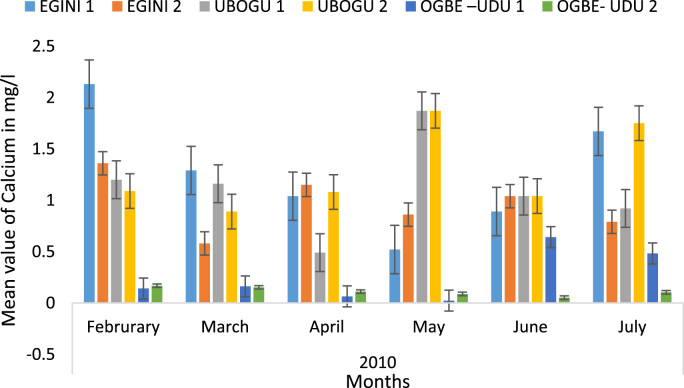
Mean Temporal and spatial variations in calcium.